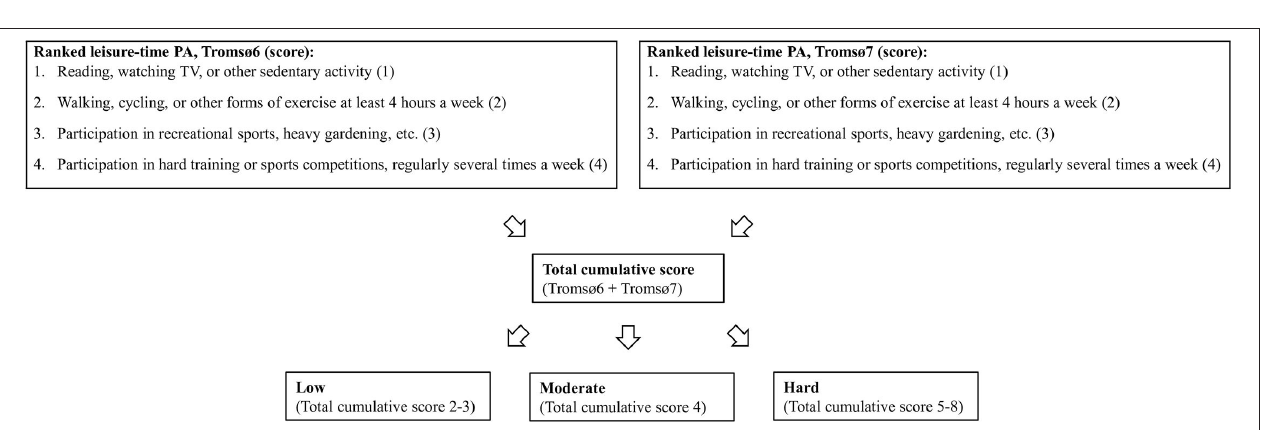
FIGURE 2 | Overview of summation of PA from Tromsø6 and Tromsø7 into cumulative PA categories: The Tromsø Study 2007–2016. PA: physical activity.